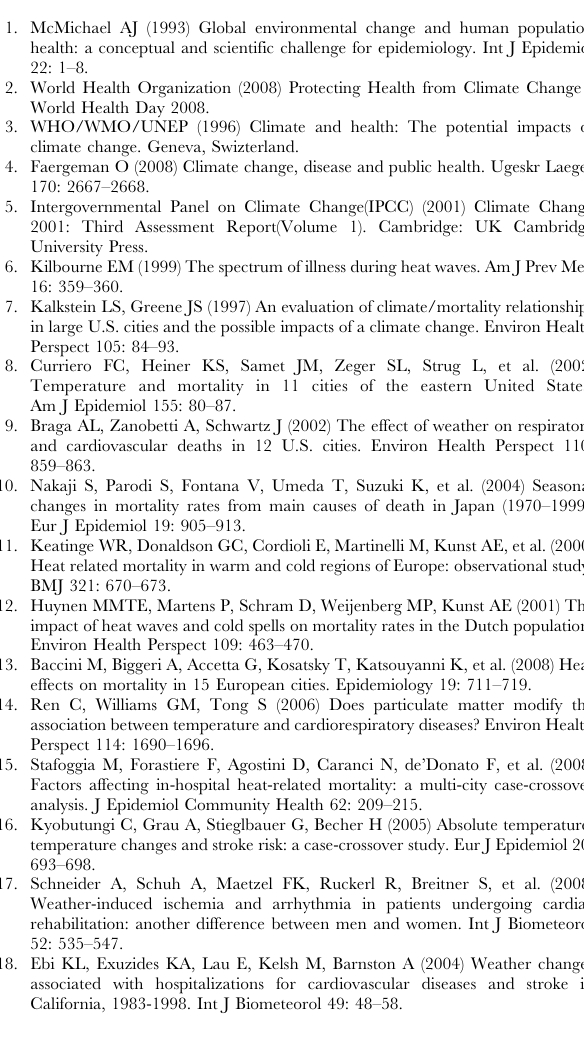
Figure S1 The associations between the mean temperature and non-external mortality, cardiovascular mortality, and respiratory mortality using model (1) in Brisbane, Australia (left side) and Los Angeles, United States (right side). (TIF)